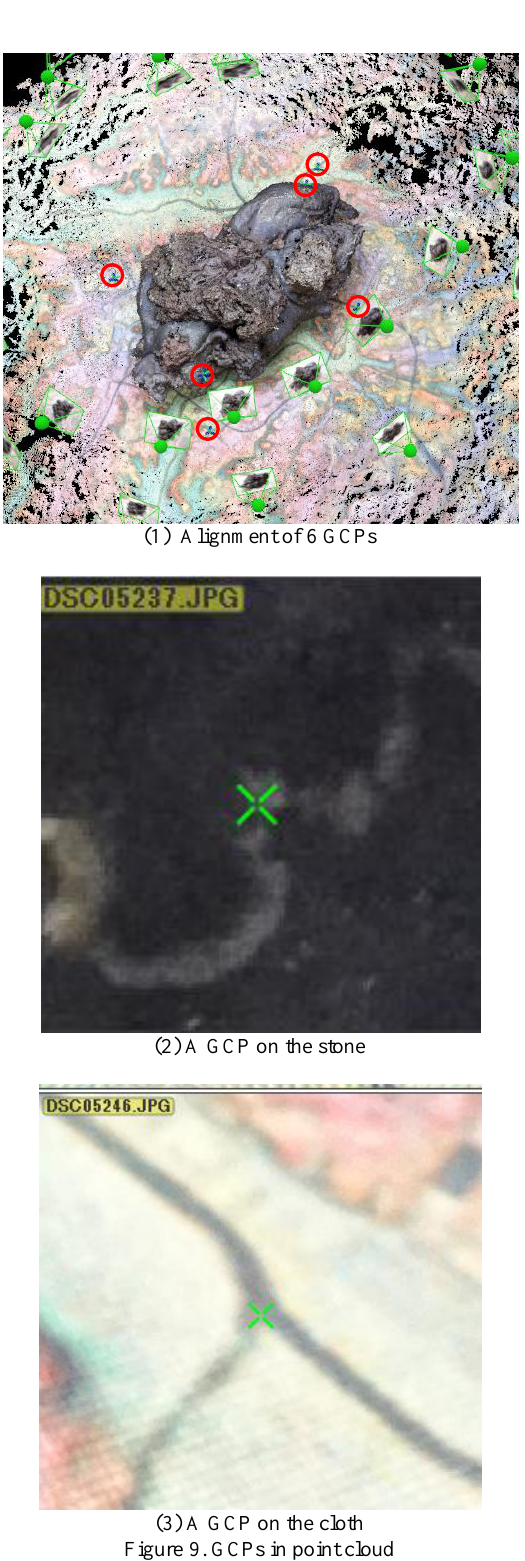
Figure 9. GCPs in point cloud